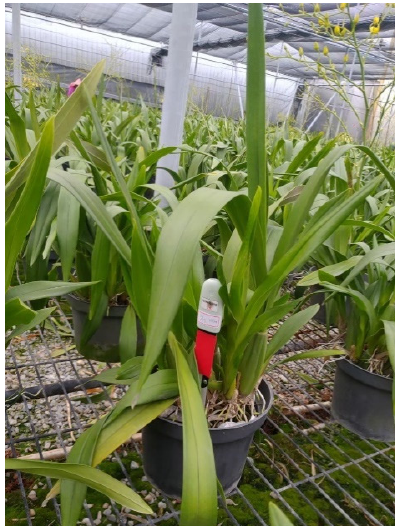
Figure 5. Sensor installation placement. Table 2. Parameters of the Xiaomi